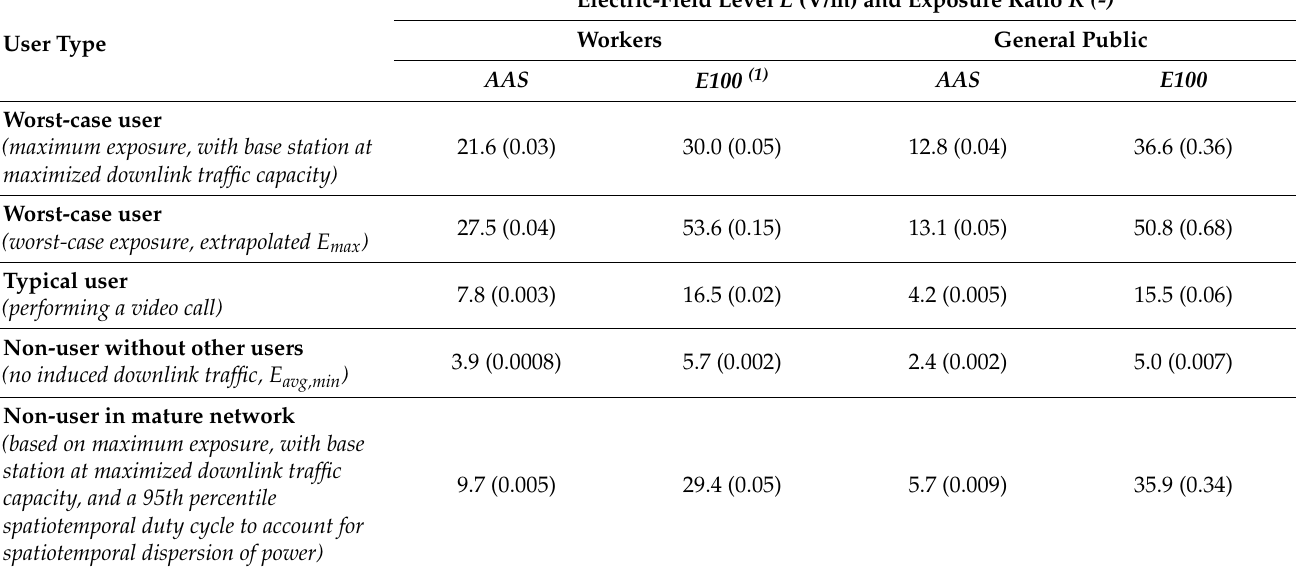
Table 4. Summary of maximum worst-case and maximum typical exposure levels ( E , in V/m) and corresponding exposure ratios R (Equation (2)) for an Advanced Antenna System (AAS) small-cell base station (at site #1) and a E100 small-cell base station (site #2), found for workers (at a distance between 0.5 m and 1 m from an operational base station) and members of the general public (at a distance of >1.3